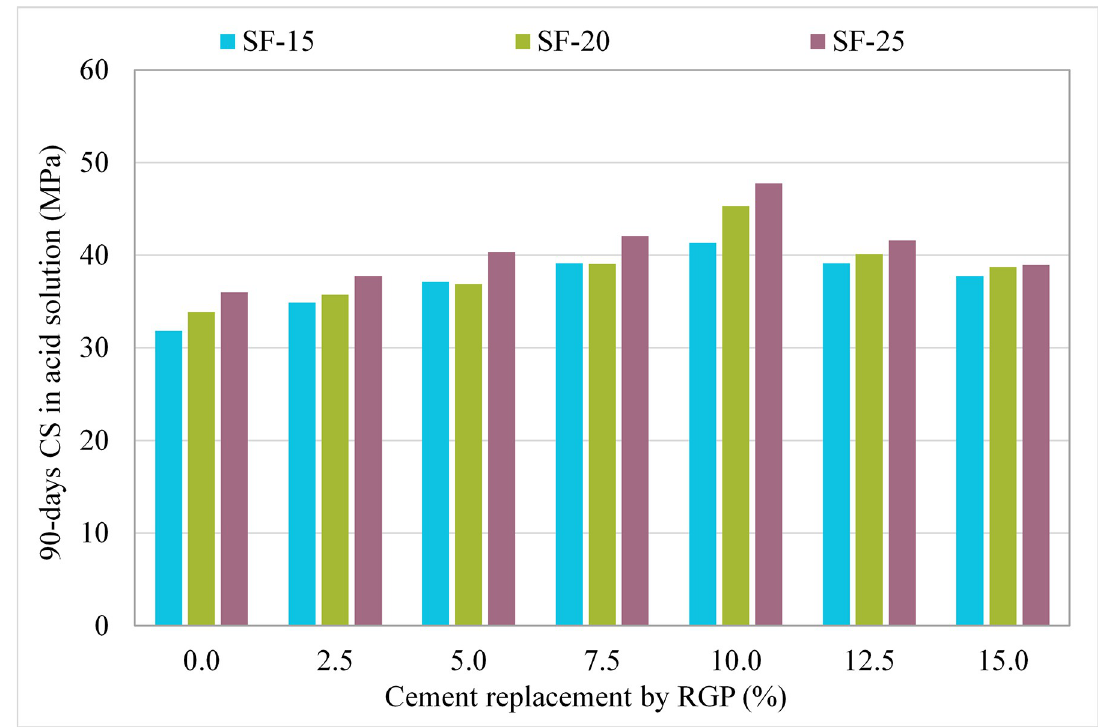
Fig 8. 90-day CS of samples incorporating RGP as a cement replacement after subjected to the acid solution.